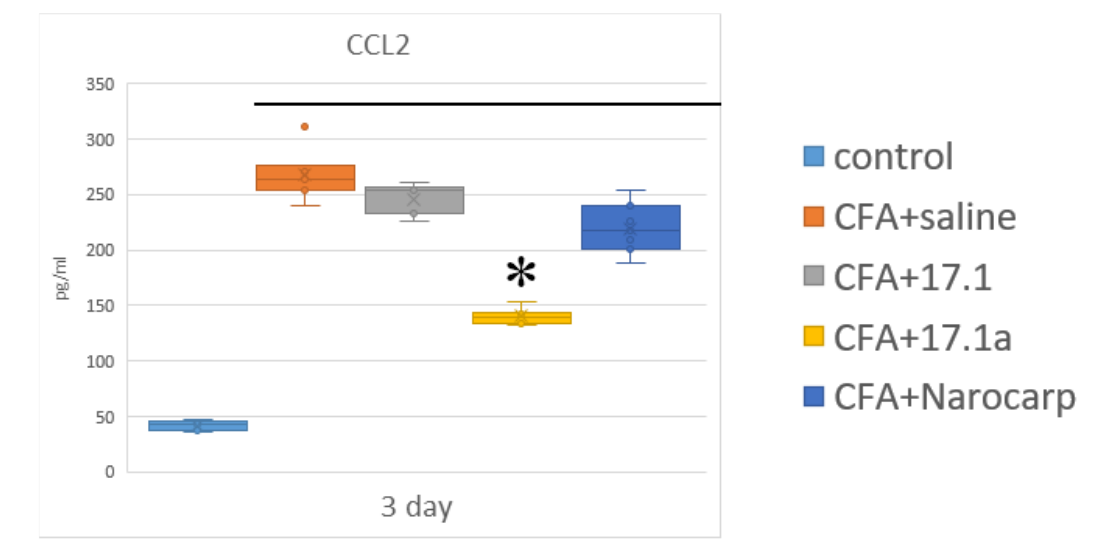
Figure 3. Changes in the level of CCL2 chemokine (CCL2) in the plasma of mice after CFA212 induced arthritis. (Control — control animals without CFA injection, CFA — animals with induced via CFA arthritis, +saline — animals were treated by phosphate buffered saline (PBS), +17.1a, +17.1, +Norocarp — animals were treated by a specified agent, n = 7 for each group). ( p -value: * < 0.05).